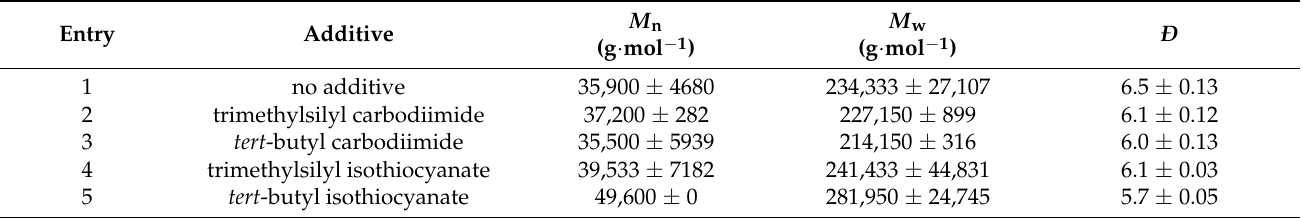
Table 7. Molecular weight distribution for the obtained polymers measured with